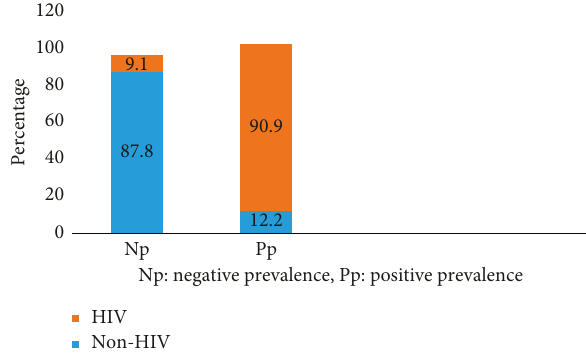
Figure 3: Prevalence of Nocardia spp. in HIV and non-HIV patients.